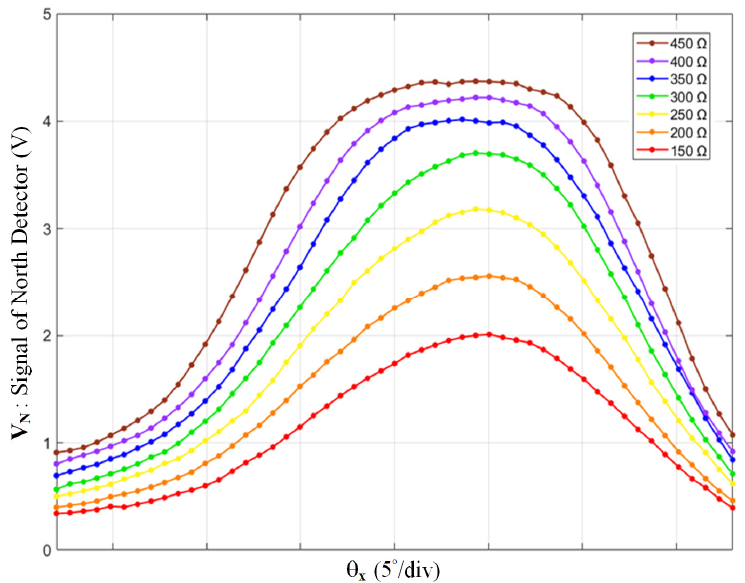
Figure 6. The north detector’s signal over θ x , with different values of phototransistor-connected resistance.